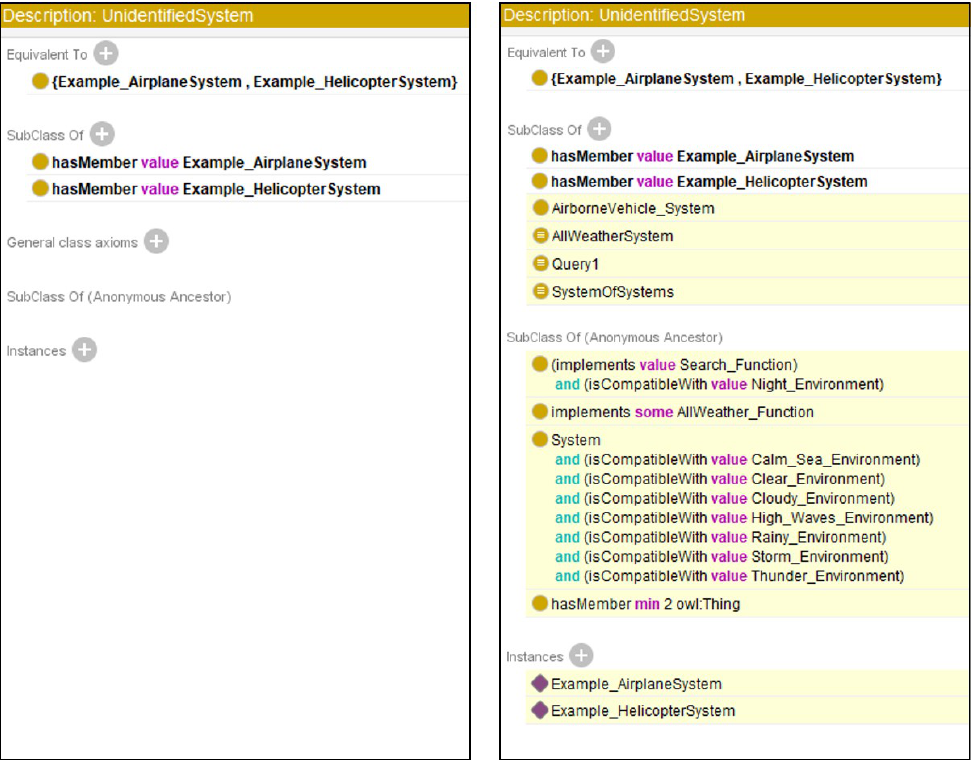
Figure 18. The UnidentifiedSystem class definition before ( left ) and after reasoning ( right ). Inferences made by the reasoner are shown with a yellow background.